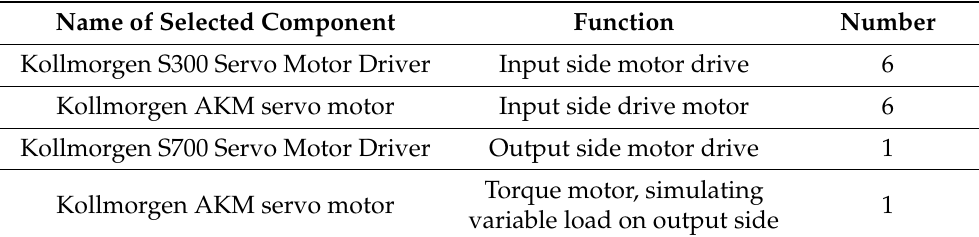
Table 1. Hardware